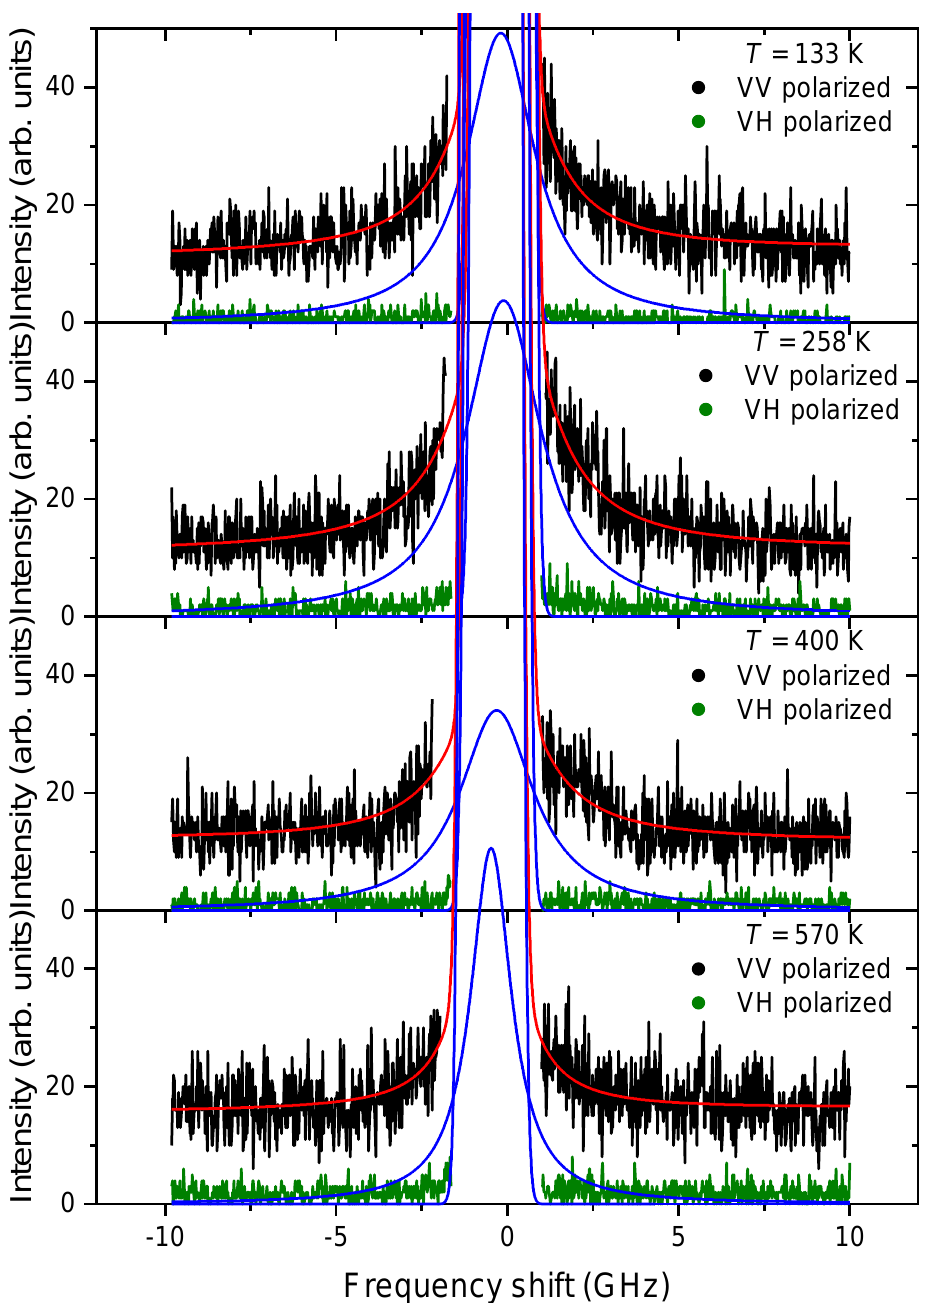
Figure 2. Polarized spectra of Brillouin light scattering in PMN (FSR = 12 GHz) and examples of their processing at different temperatures. The solid red line is the result of calculations using expression (4); fitting was carried out for the VV polarized spectra. Blue line is the contour of the QELS obtained as a result of data fitting (see text).